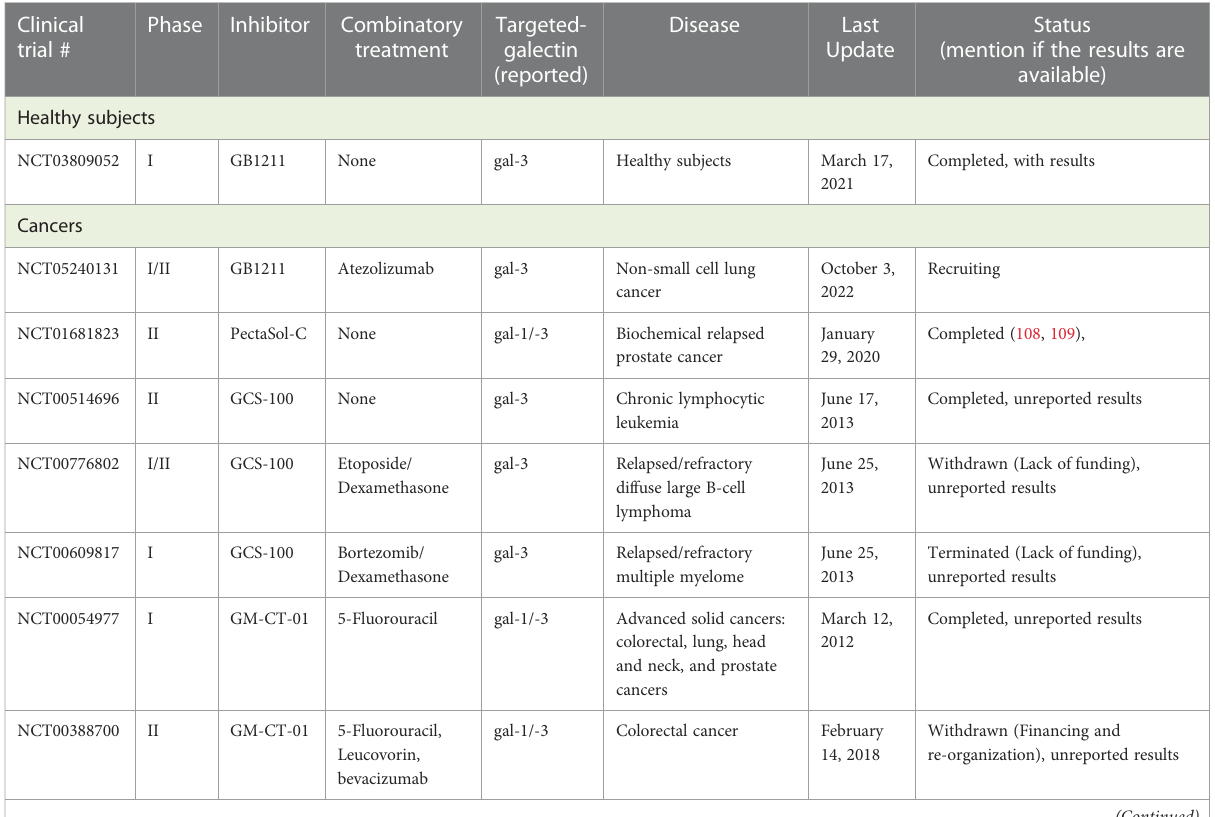
TABLE 2 Clinical trials with galectin inhibitors. Clinical trial